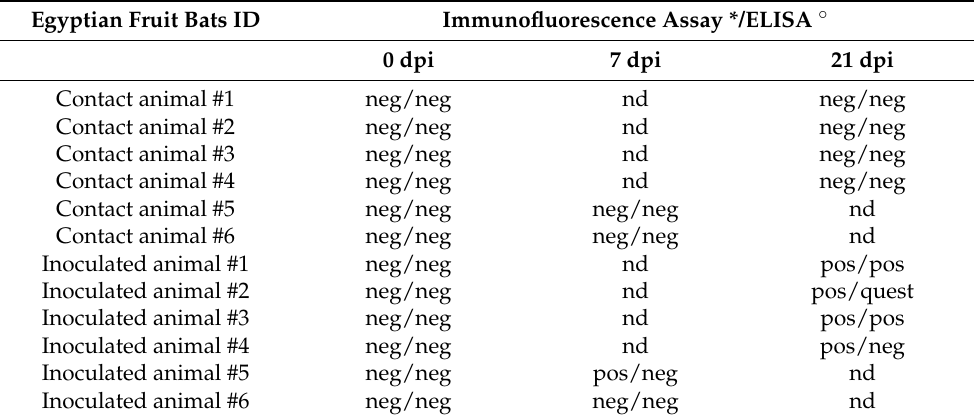
Table 3. Summary of antibody detection from samples of six fruit bats inoculated with A/bat/Egypt/381OP/2017 (H9N2) and six contact Egyptian fruit bats. Egyptian Fruit Bats ID Immunofluorescence Assay */ELISA